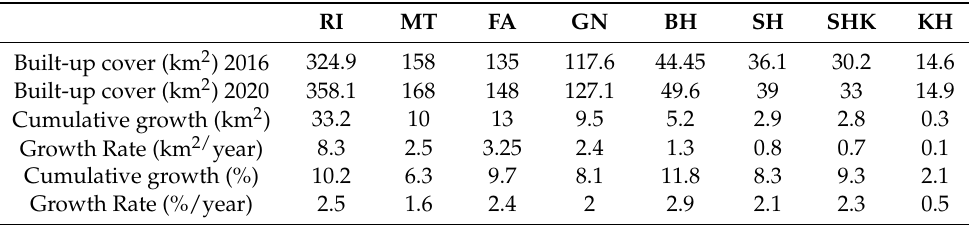
Table 10. Expansion of impervious surface area of cities in 2016 and 2020.